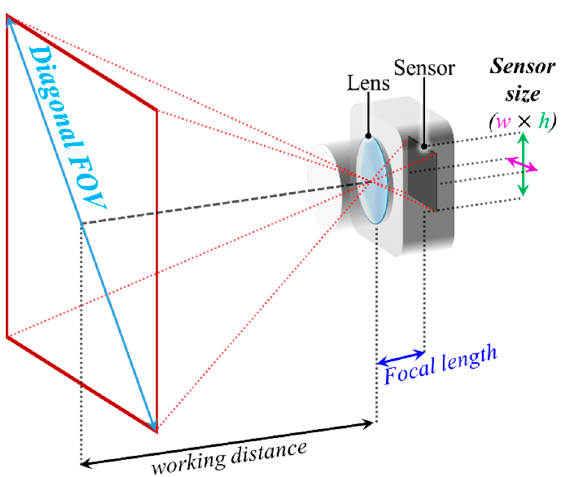
Figure 5. A brief schematic of a digital camera.